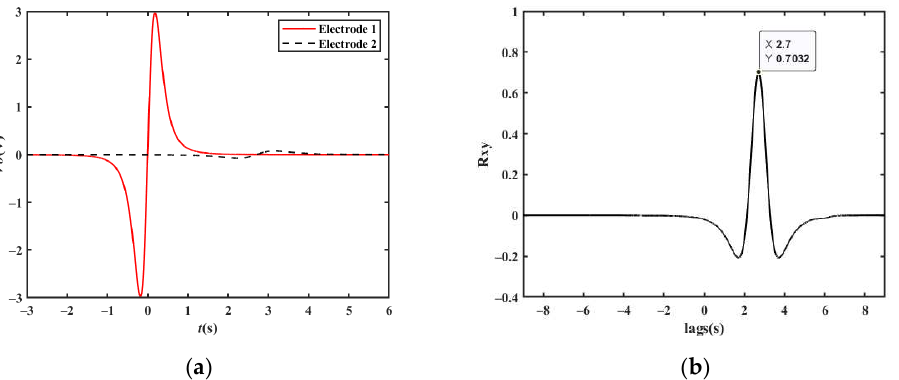
Figure 13. Simulation results of lane changing of a single vehicle: ( a ) simulation results at a velocity of 20 km/h; ( b ) cross-correlation results at a velocity of 20 km/h.